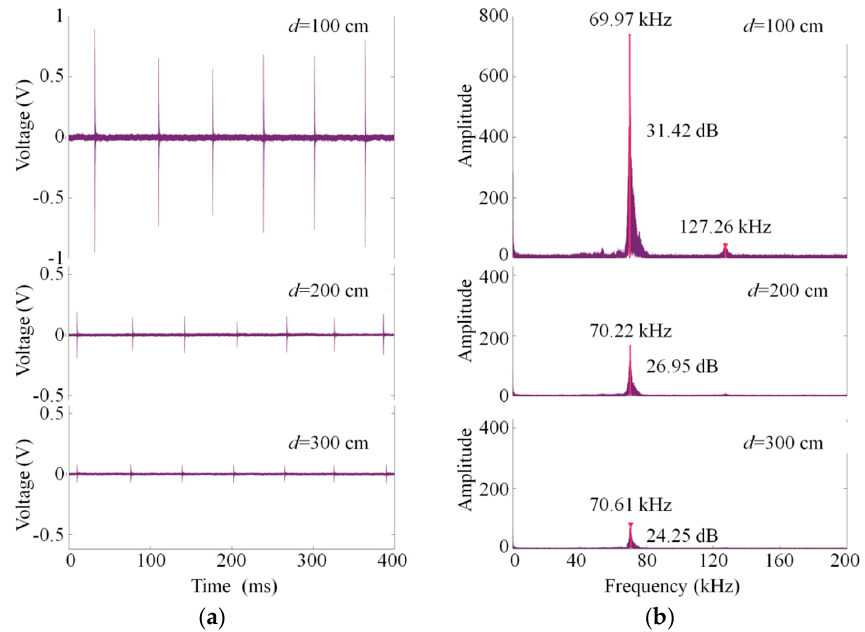
Figure 8. Ultrasonic signal waveforms at d = 100 cm, 200 cm, and 300 cm in ( a ) the time domain; ( b ) the frequency domain.